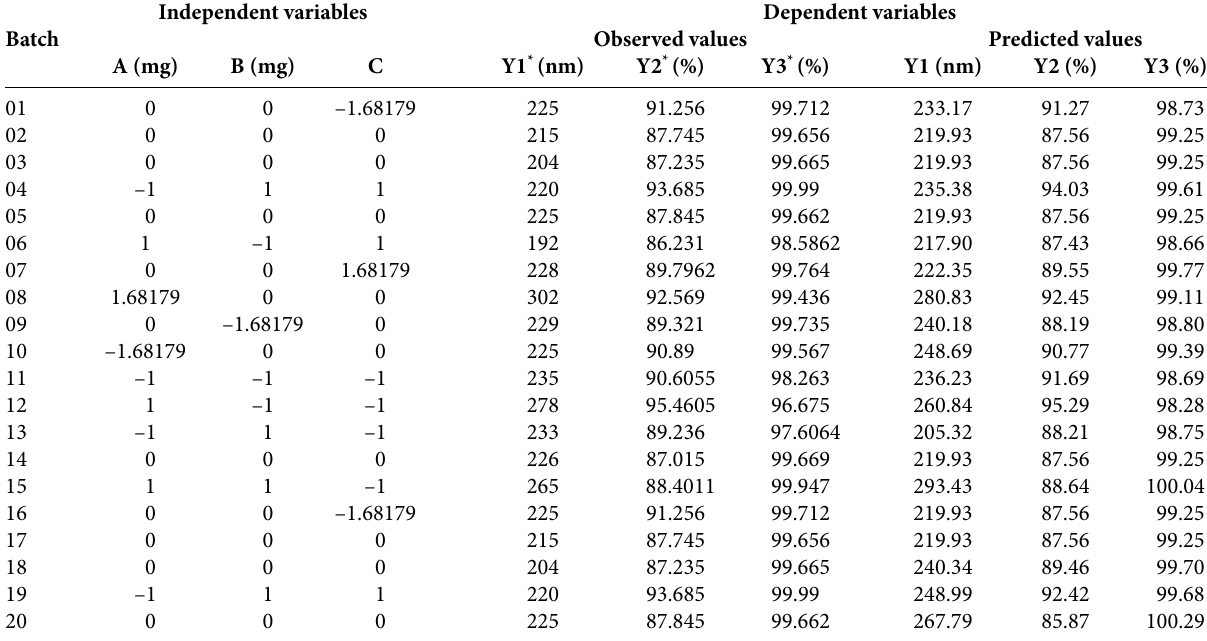
Table 7. Central composite design matrix with observed and predicted values of